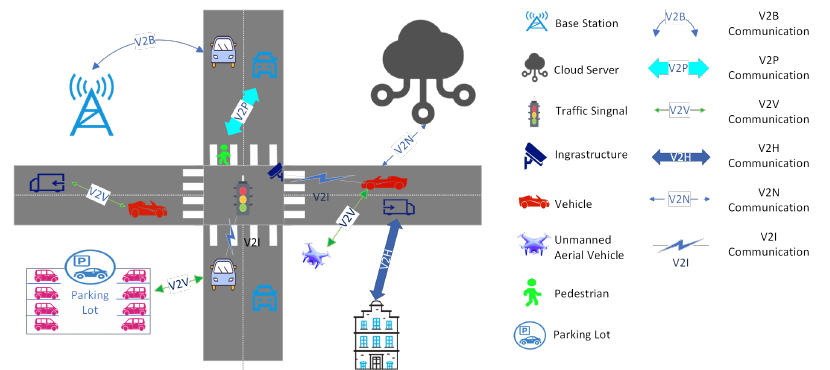
Figure 2. In vehicle network.